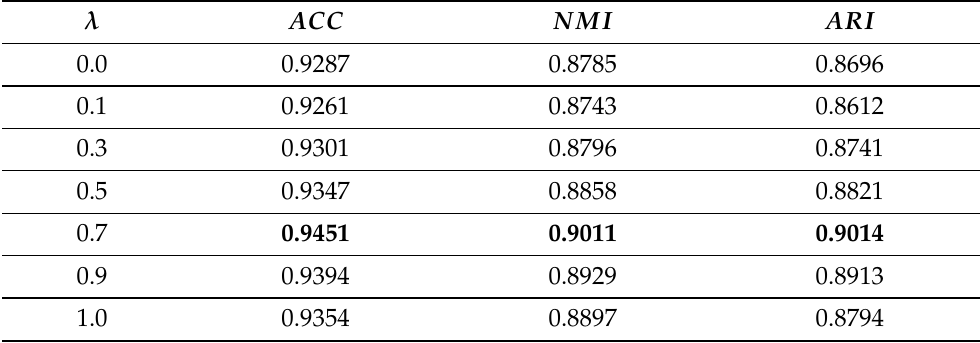
Table 5. Clustering results with different λ